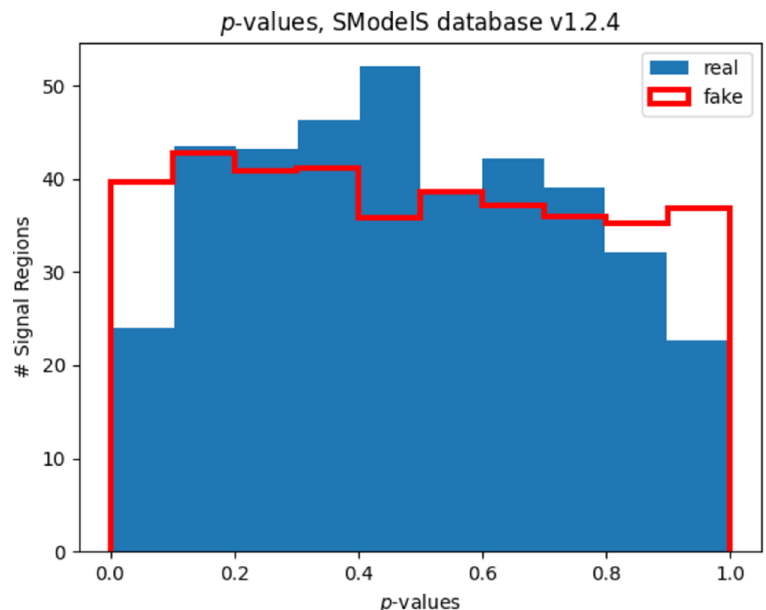
Figure 7 . Distribution of p -values from EM results in SModelS . The red histogram shows the distribution for a few “fake” databases (but normalized to a single database), where the observed data has been obtained by sampling the background expectations as explained in the text. The solid blue histogram displays the same distribution, but for the real data. In order to avoid distortions due to small numbers of events, only signal regions with at least 3.5 expected events were